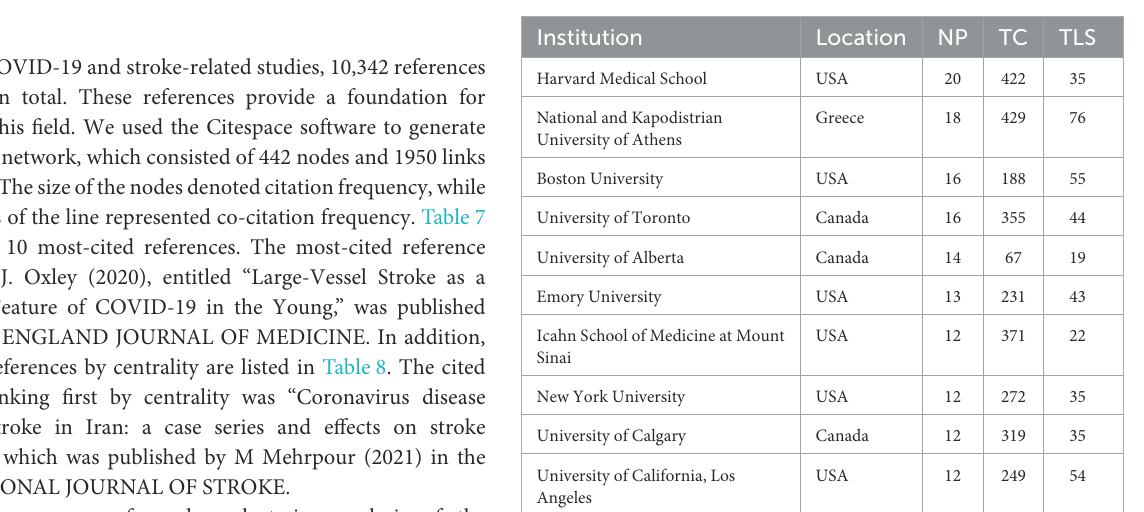
TABLE 4 The most prolific institutions in the field of COVID-19 and stroke